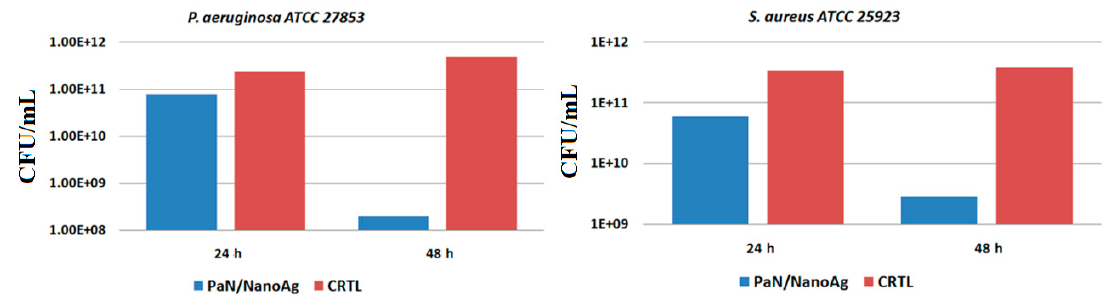
Figure 12. Graphic representation of the results obtained after CFU/mL count for P. aeruginosa and S. aureus biofilms developed in the presence of regular (control) and nano-coated WDs.